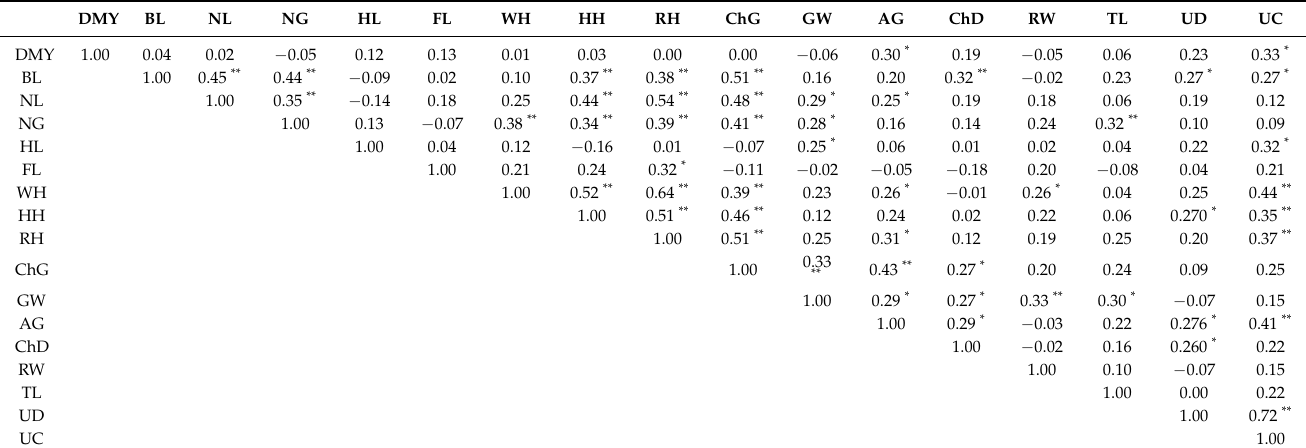
Table 2. Correlation coefficients among body measurements (cm) and daily milk yield (kg).